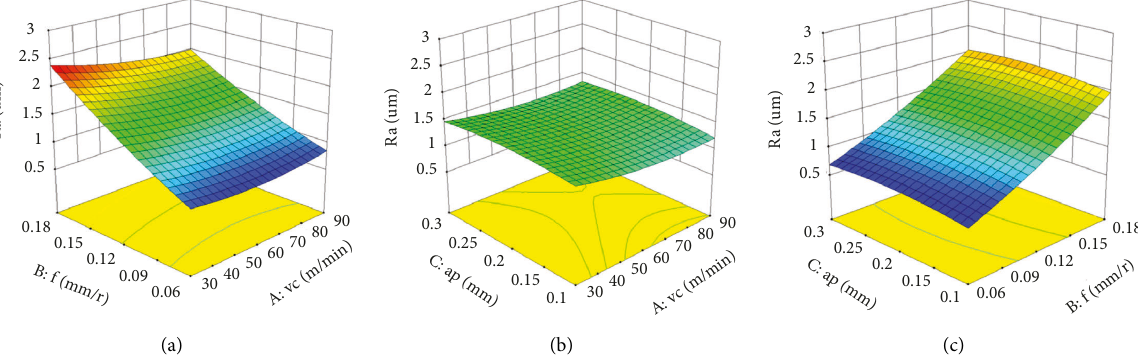
Figure 3: The influence of the machining factor on Ra . (a) Interaction of f and v of a p and f on Ra .